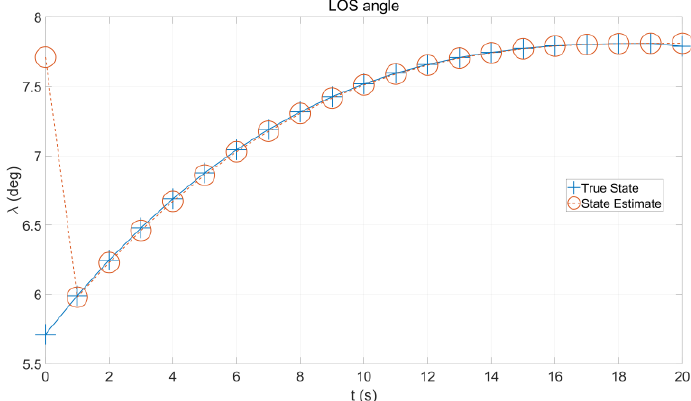
Figure 8. Trajectory of the LOS angle and corresponding estimates.